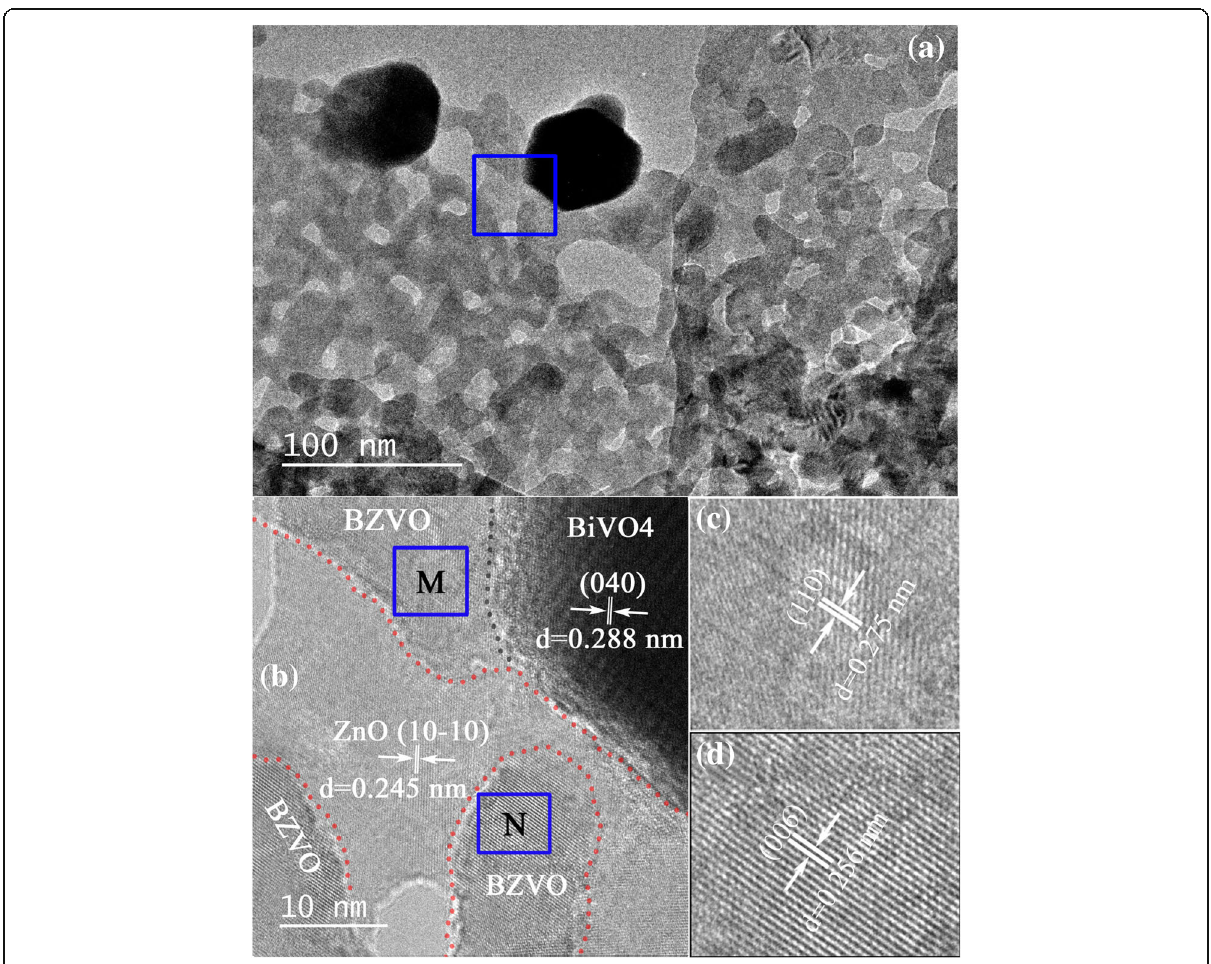
Fig. 3 a TEM image of ZB_0.05, showing porous sheetlike nanostructure. b High-resolution TEM image for the enlarged region remarked with blue rectangle in the TEM image, clearly displaying BZVO domains embedding in ZnO lattice. Enlarged BZVO domains remarked with M and N blue rectangles are separately shown in c and d ,